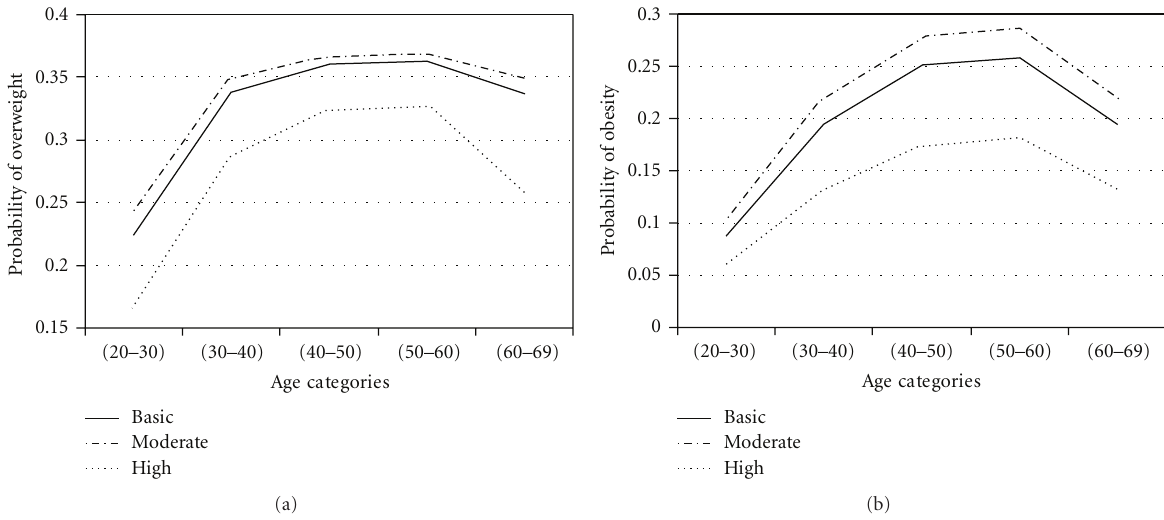
Figure 1: Probabilities of overweight and obesity across age groups for education level.